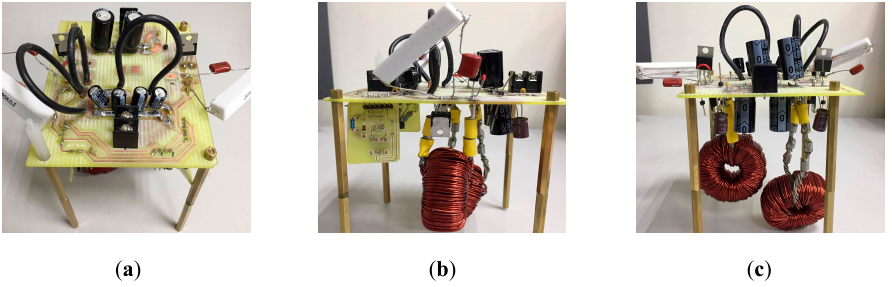
Figure 12. Realized combined boost converter prototype. ( a ) Top view; ( b ) Front view; ( c ) Side view.